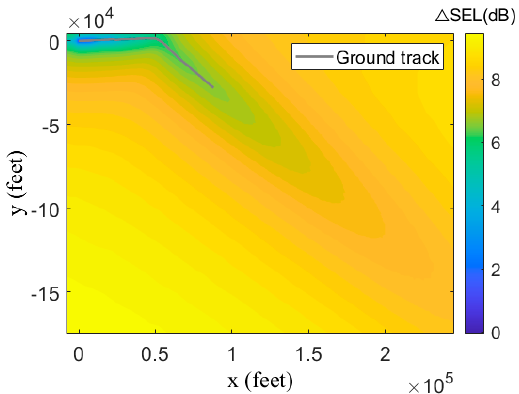
Figure 19. Effect of the atmospheric properties on the aircraft noise impact. Differences in SEL induced by a variation in both temperature and relative humidity (AD6—AD3).